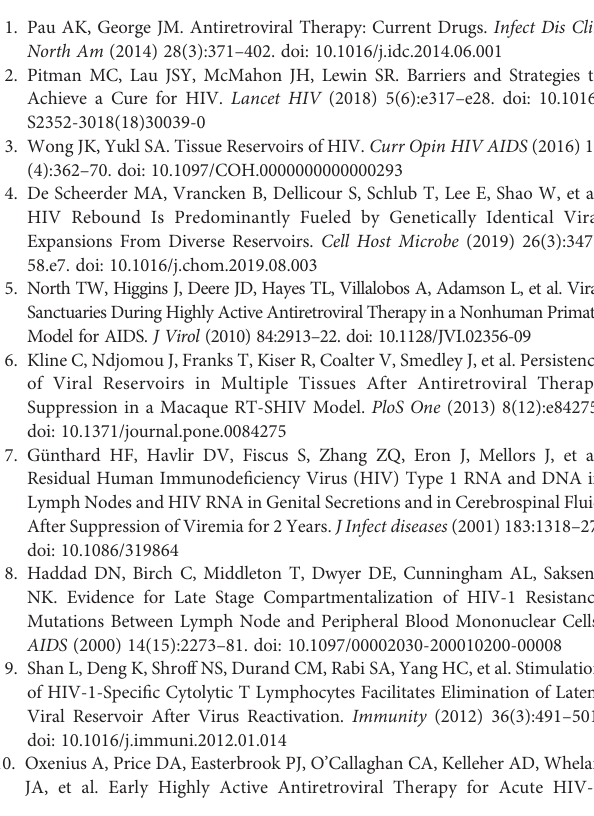
Supplementary Figure 1 | Phylogenetic relatedness of the gag-protease sequences from reservoirs, pre-therapy plasma and their matched recombinant viruses. A maximum likelihood tree showing the phylogenetic relatedness of HIV-1 subtype C gag-protease sequences from the pre-therapy plasma (in blue), peripheral blood mononuclear cells (in black), lymph nodes (in red) and respective